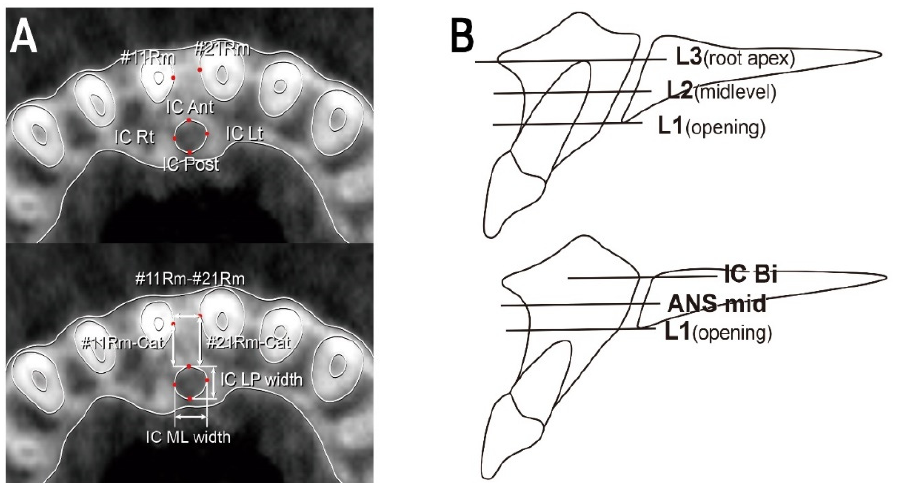
Figure 3. Assessment of incisive canal (IC) and central incisor relationship. Landmarks and linear measurements. ( A ). #11Rm, the most medial point of the right maxillary central incisor root; #21Rm, the most medial point of the left maxillary central incisor root; IC Lt, the most lateral point of the left contour of the IC; IC Rt, the most lateral point of the right contour of IC, IC Ant, the most anterior point of the incisive canal; IC Post, the most posterior point of IC; #11Rm-#21Rm, mediolateral distance between #11Rm and #21 Rm; #11Rm-Cat, anteroposterior distance between #11Rm and anterior margin of IC; #21Rm-Cat, the anteroposterior distance between #21Rm and anterior margin of IC; IC LP width, labiopalatal width of IC; IC ML width, mediolateral width of IC ( B) . Three vertical levels of the incisive canal: L1, the level at which the IC begins on the oral side; L2, midlevel between L1 and L3; L3, root apex level; IC Bi, the level at which the IC bifurcates in the nasal cavity; ANS mid, midlevel between L1 and the level passing ANS. All levels were parallel to the Frankfort horizontal plane.